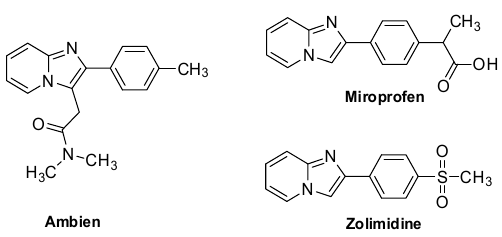
Figure 1. Examples of bioactive agents possessing imidazo[1,2- a ]pyridine core.